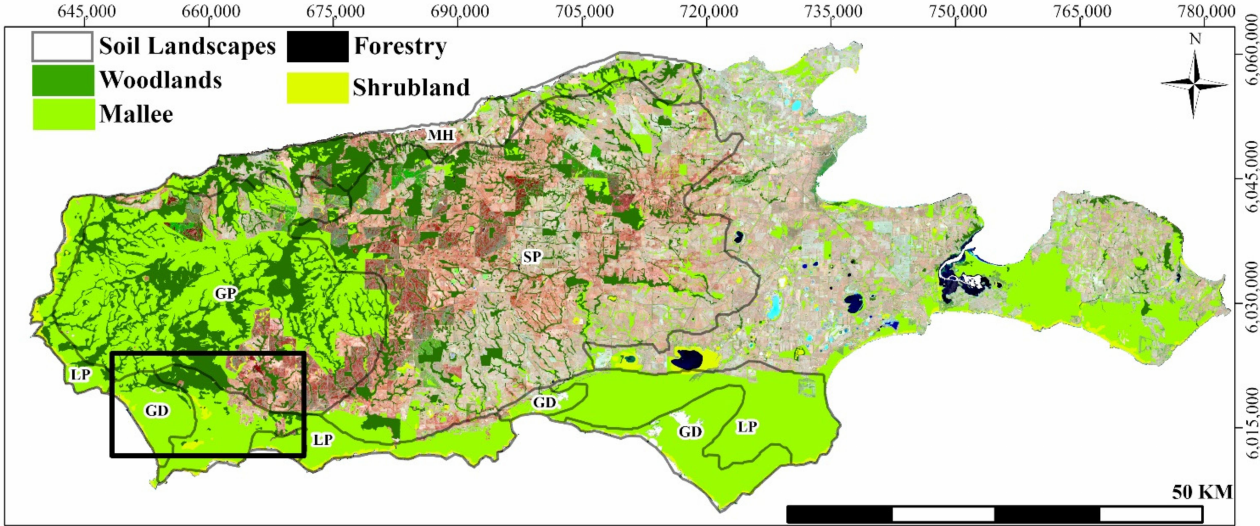
Figure 2. Landscape unit classifications of Kangaroo Island from Northcote [83], dominant native vegetation communities and plantation forests of hardwood and softwood species. Extent indicator in the SW part of island refers to Figure 3.